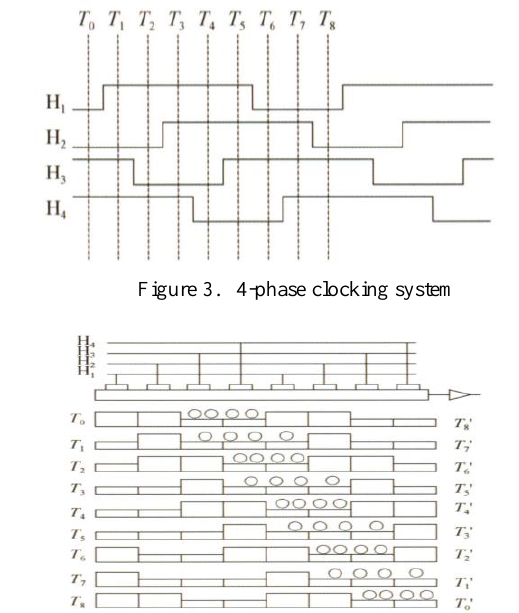
Figure 4. Charge motion driven by 4-phase